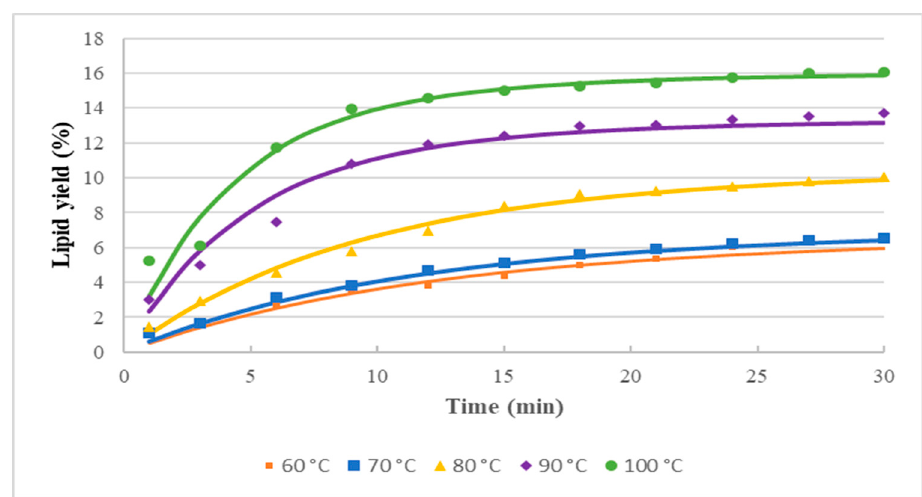
Figure 4. Relationship between time and extraction yield of Nannochloropsis sp. microalgal lipids using MAE-brine, according to Patricelli kinetic model.